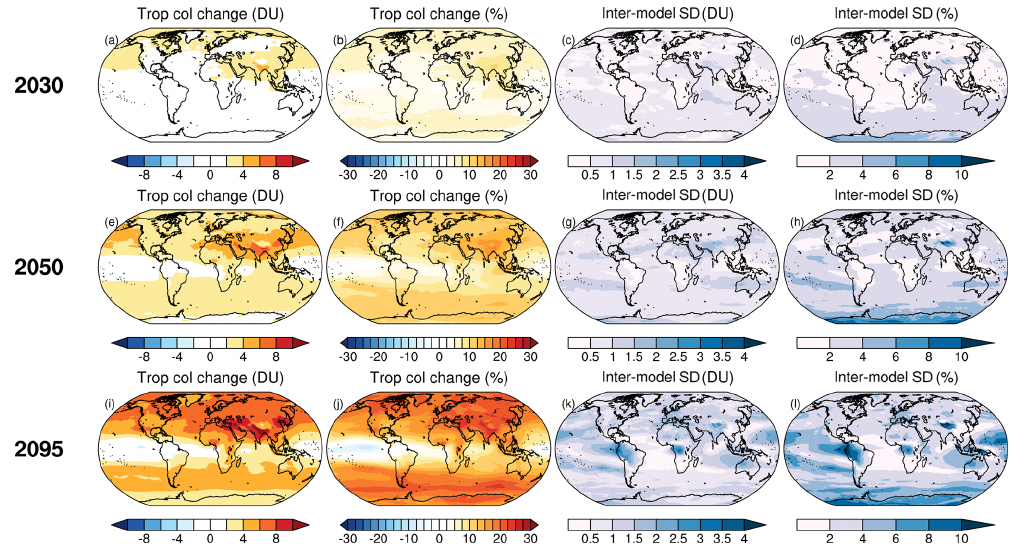
Figure 12. Future change in tropospheric column ozone (TCO) relative to the present day. The same as Fig. 11 but for changes in TCO in Dobson units (DU) or percent (%), as appropriate.